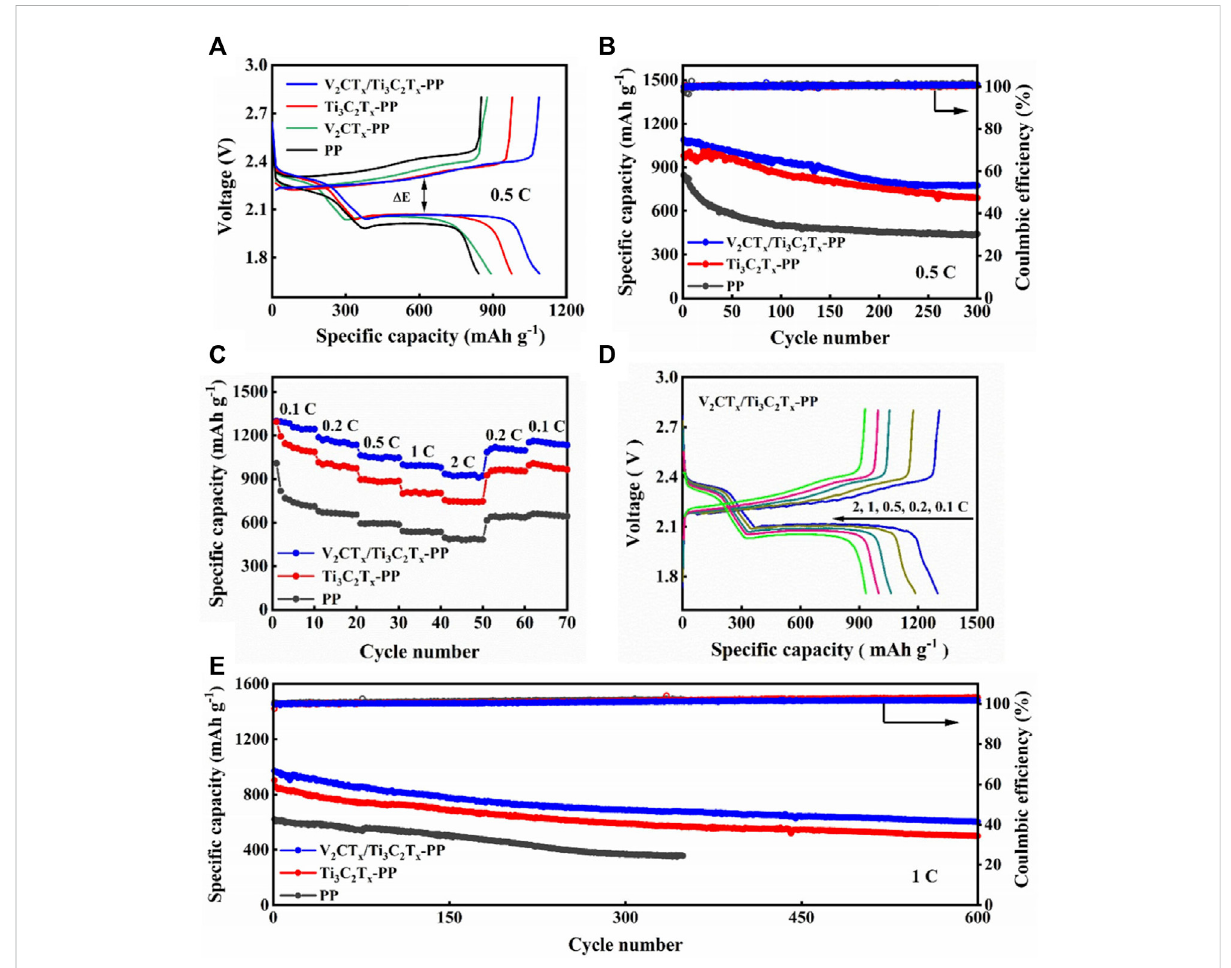
FIGURE 3 (A) GCD curves of V 2 CT x /Ti 3 C 2 T x -PP, Ti 3 C 2 T x -PP, V 2 CT x -PP, and PP cells at 0.5 C. (B) Cycling performance of V 2 CT x /Ti 3 C 2 T x -PP, Ti 3 C 2 T x -PP, and PP cells at 0.5 C. (C) Rate performance of V 2 CT x /Ti 3 C 2 T x -PP, Ti 3 C 2 T x -PP, and PP cells. (D) GCD curves of the V 2 CT x /Ti 3 C 2 T x -PP cell at current densities of 0.1, 0.2, 0.5, 1, and 2 C. (E) Cycling performance of V 2 CT x /Ti 3 C 2 T x -PP, Ti 3 C 2 T x -PP, and PP cells at 1